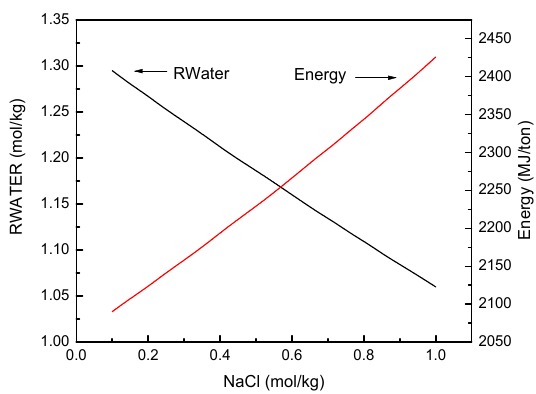
Figure 11. The effect of feed solution concentration on the FO process performance using DP as the draw solute.